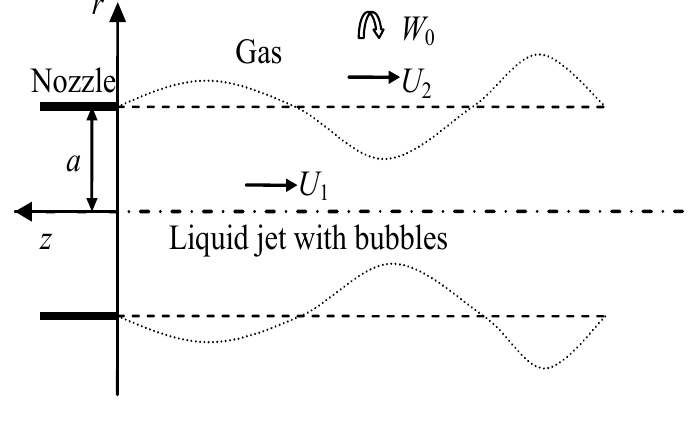
Figure 1. Physical model.